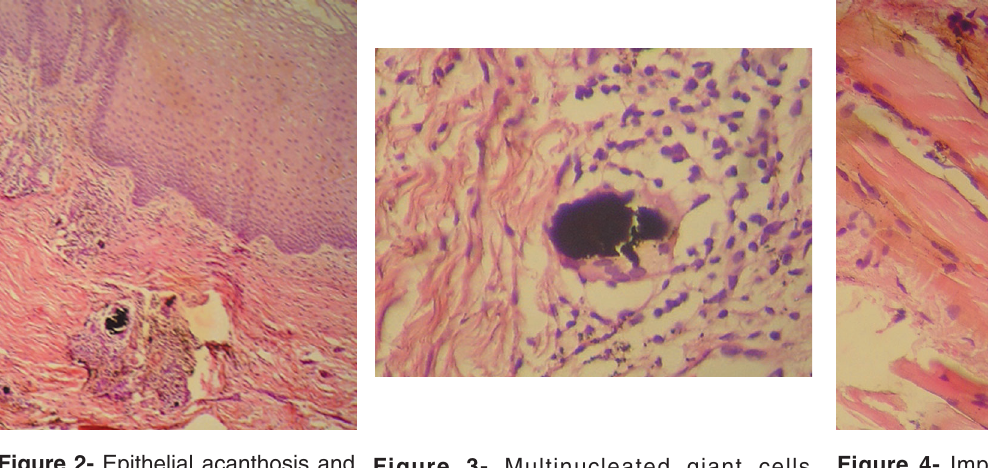
Figure 4- Impregnation of muscle cells by brownish-black pigments (Hematoxylin and eosin, ×400)